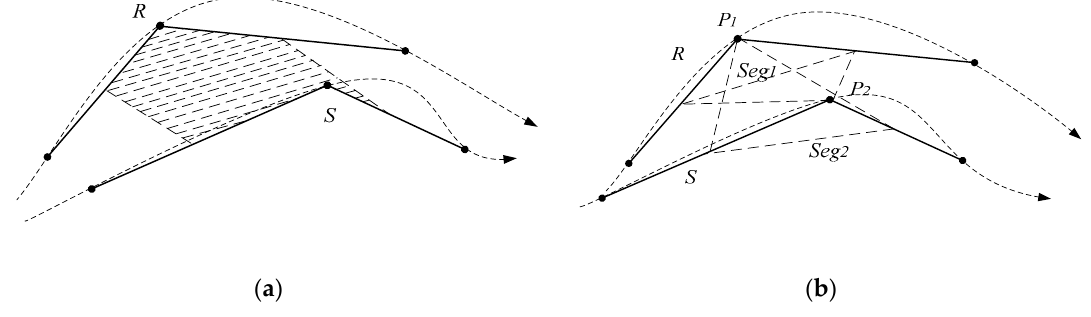
Figure 4. Two computation methods of the proxy sub-trajectory distance. ( a ) The area enclosed by the two proxy trajectories; and ( b ) a simplified calculation method.